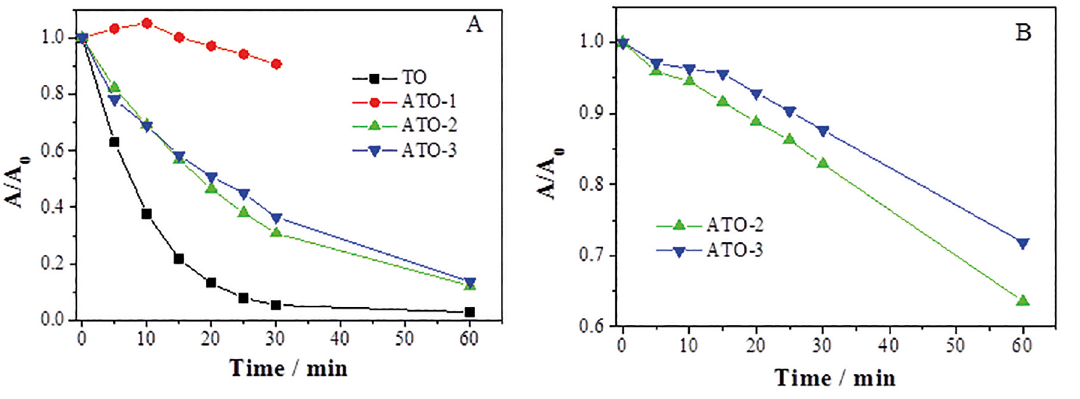
Figure 8. Photocatalytic behavior of RNO oxidation with different photocatalysts prepared by autoclave syntheses using (A) UV and (B) visible radiation (250 mg of catalyst; initial concentration of RNO = 2.0 x 10 -5 mol L -1 ).